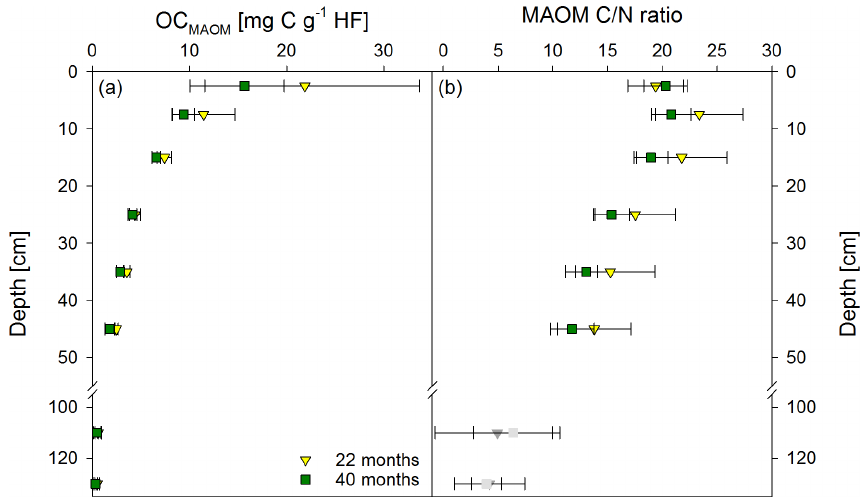
Figure 3. Mean OC contents in the heavy fraction (HF) (a) and mean C / N ratios (b) of the mineral-associated organic matter fraction (MAOM) from both sampling times, 22 and 40 months after labeled litter application ( n = 6; error bars represent the standard deviation). Nitrogen contents in the HF were corrected for extractable nitrate and ammonium contents; N contents in samples below 100cm were unreliable, and C / N ratios are therefore marked in grey.